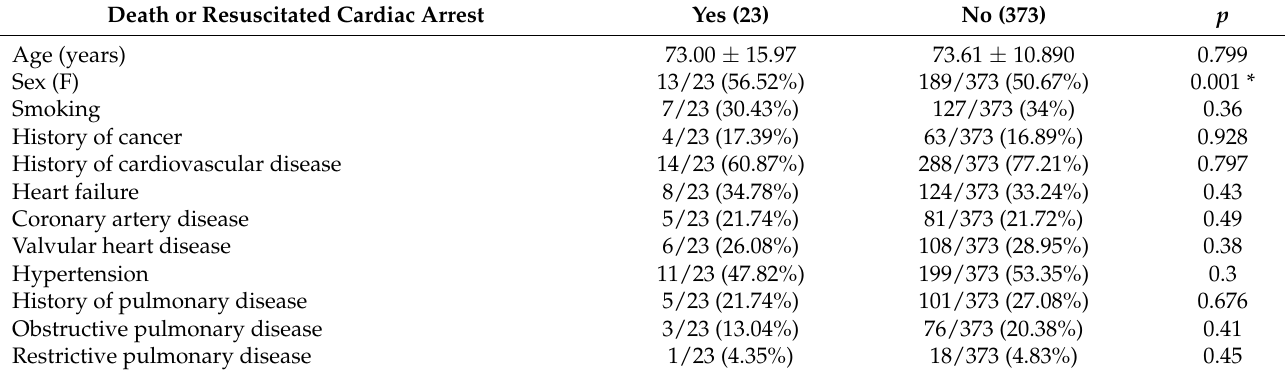
Table 3. Comparative baseline demographic, clinical and laboratory parameters in patients with and without in hospital death or resuscitated cardiac